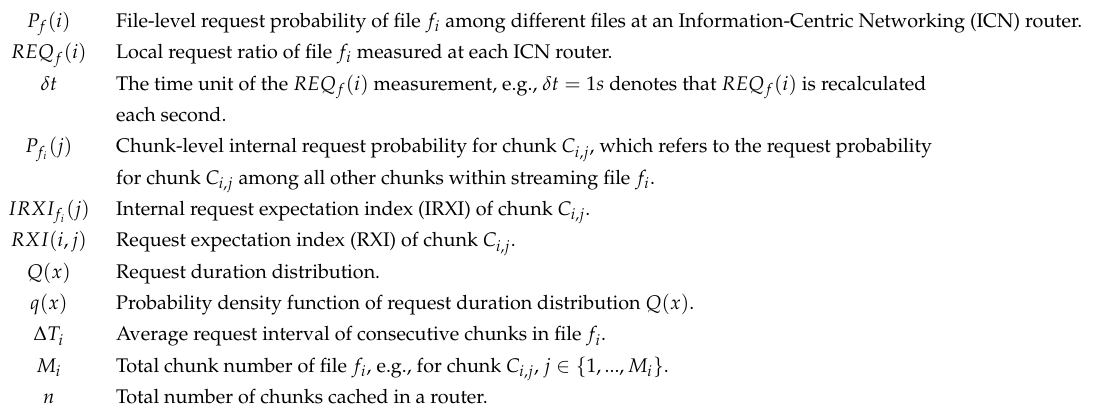
Table 1. Notation. REQ: Request